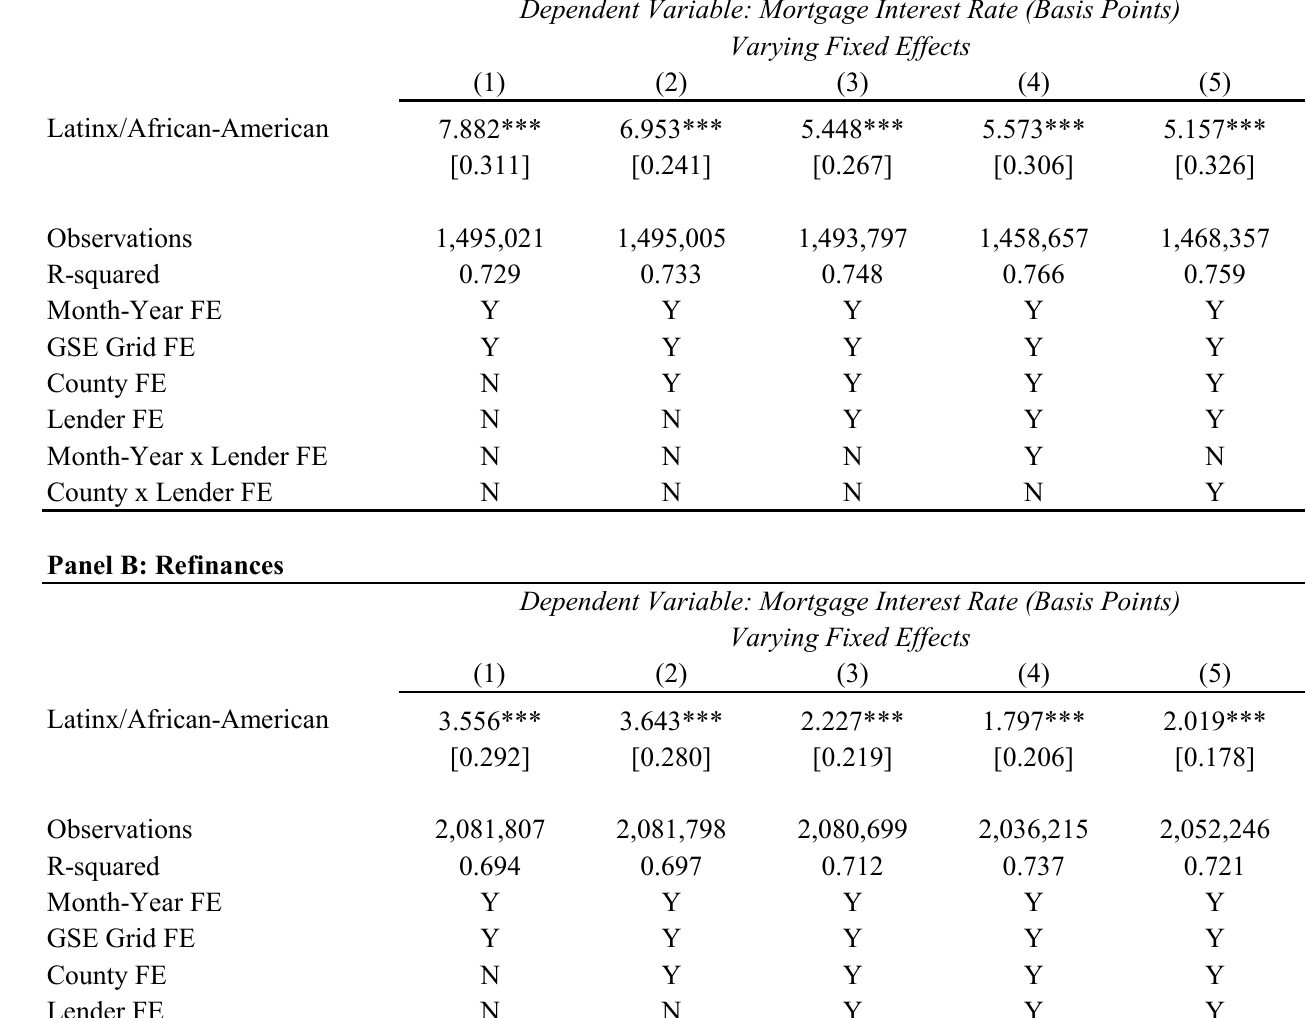
Table 4: Interest Rate Discrimination - Robustness to Lender and Geography Fixed Effects